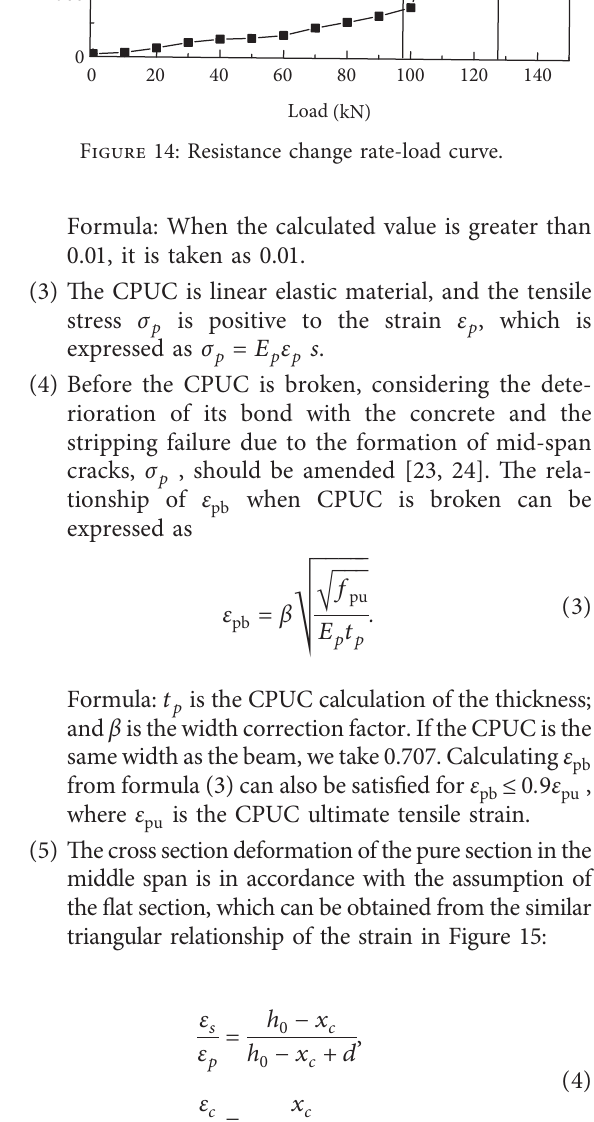
Figure 15: Bending calculation model.